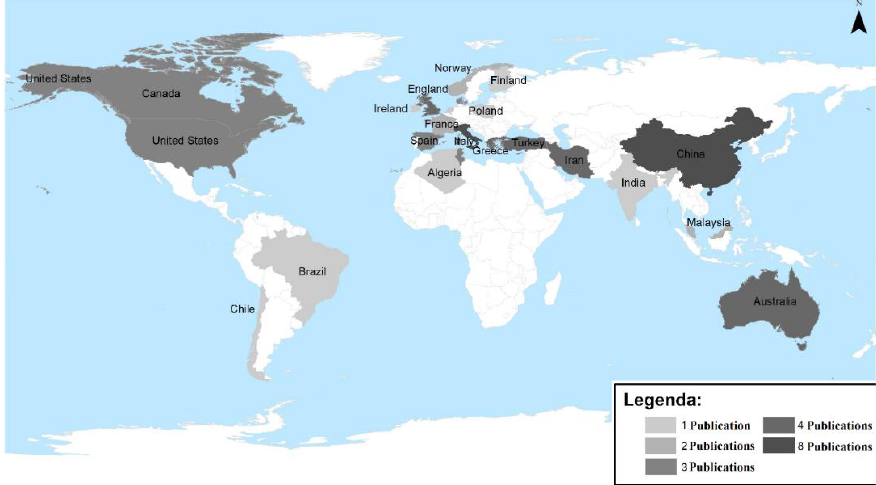
Figure 5. Geographic distribution of publications on residential solar heating with flat-plate solar collectors from 1993 to 2019.